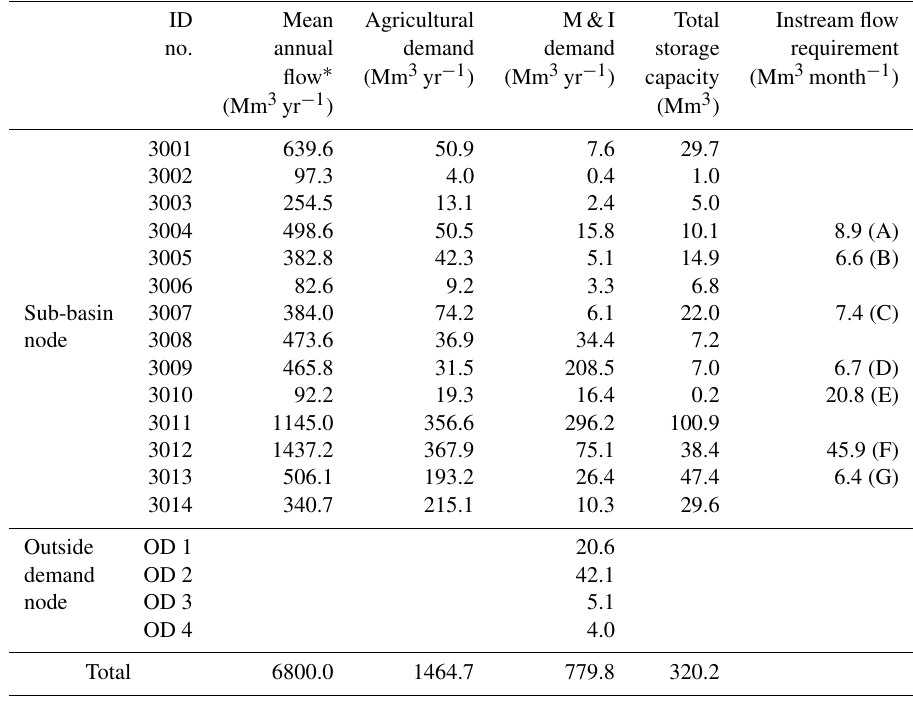
Table 1. Annual agricultural and M&I demands per demand node, and the minimum instream flows from the sub-basins corresponding to the seven locations. ID Mean Agricultural M&I Total Instream flow no. annual demand demand storage requirement flow